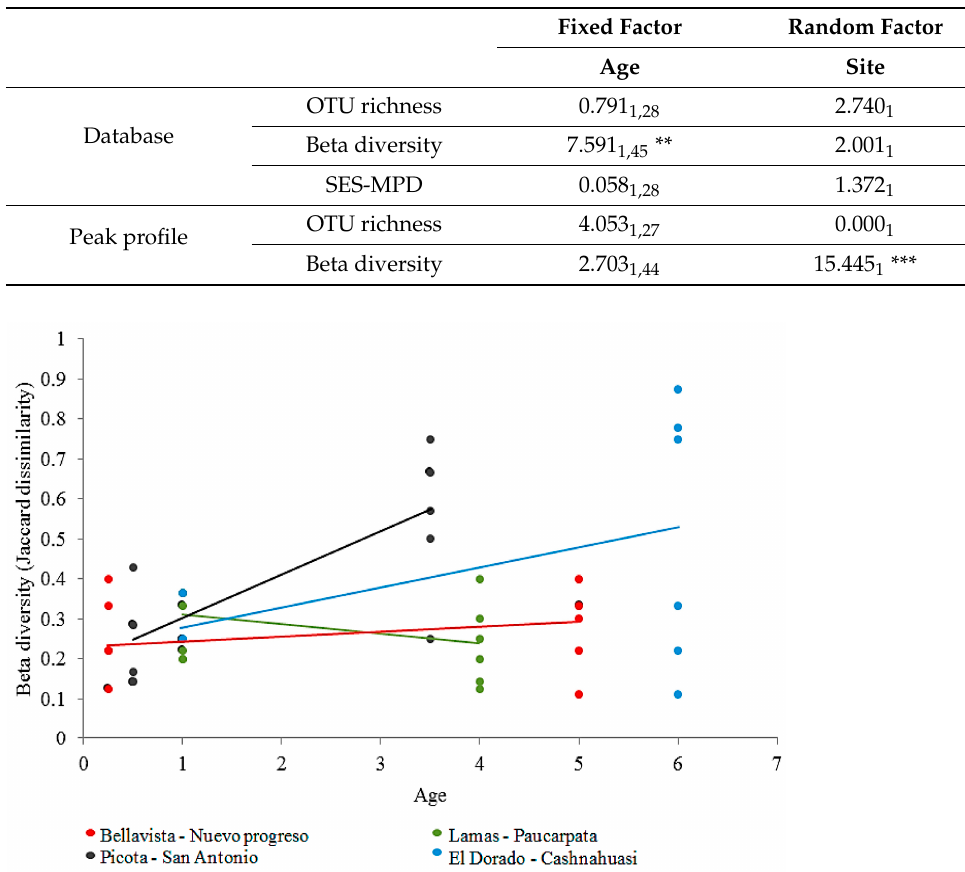
Figure 2. Variation of beta diversity (Jaccard dissimilarity across sample pairs, y -axis) of AM fungal communities across crop ages (years, in x -axis) and localities (different color).